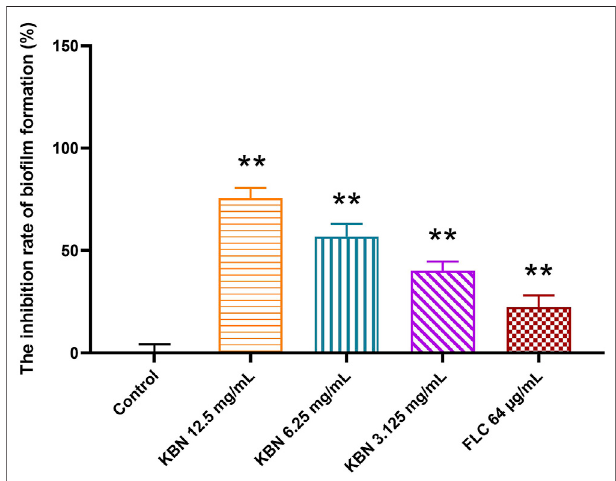
FIGURE 4 | Effects of different concentrations of KBN on FLC-resistant C.albicans 901bio fi lmformation.Dataareexpressedasthemean ± SDofthe independent assays in sextuplicate. pp p < 0.05 as compared to the control group.